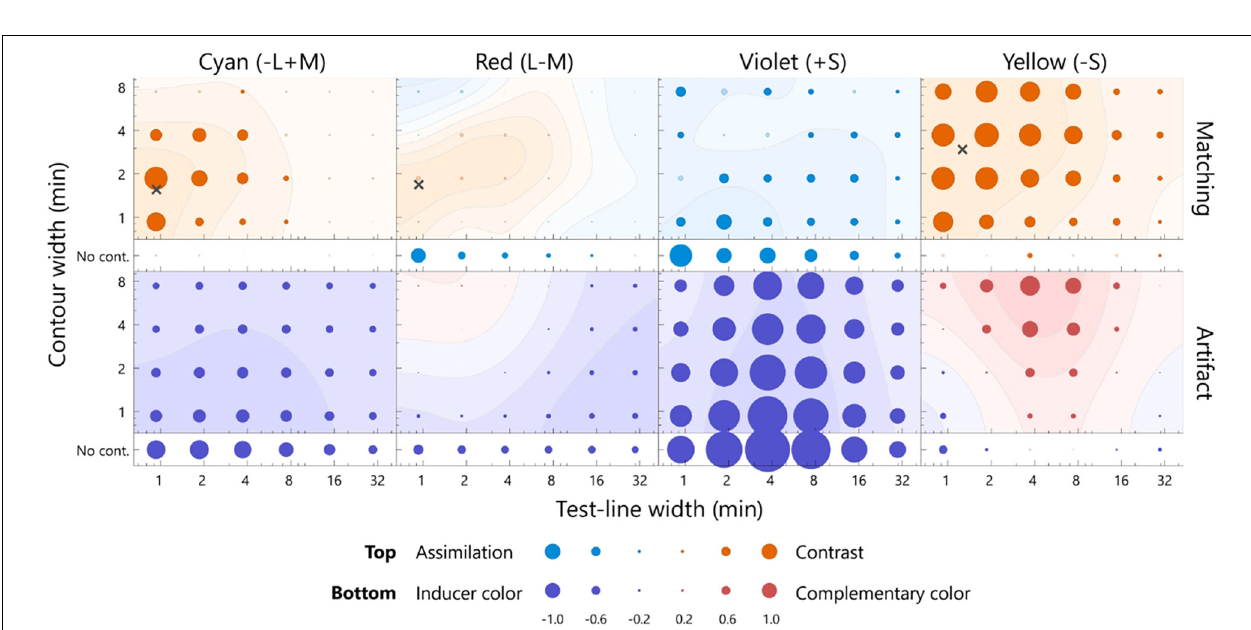
FIGURE 5 | The averaged matching across all participants (top row) and the estimated artifacts (bottom row) for the dark test line. The format is the same as in Figure 4 . Note: the scale of the bubble size is different, as shown in the key below. The points inducing the largest color shift are indicated by cross marks, with the exception of the violet inducer, given that the positive contrast effect was not observed. The actual values of the matching and artifact were shown in Supplementary Figure 3